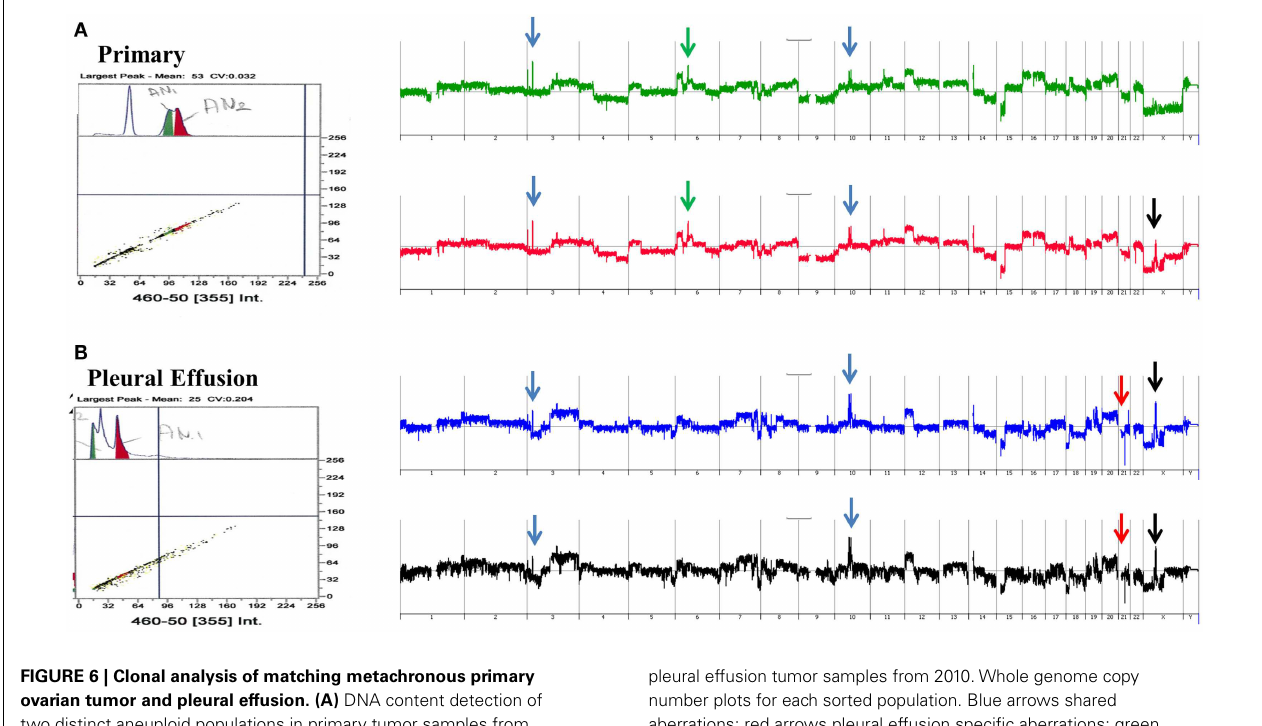
FIGURE 6 | Clonal analysis of matching metachronous primary ovarian tumor and pleural effusion. (A) DNA content detection of two distinct aneuploid populations in primary tumor samples from 2009.Whole genome copy number plots for each sorted population. (B) DNA content detection of two distinct aneuploid populations in